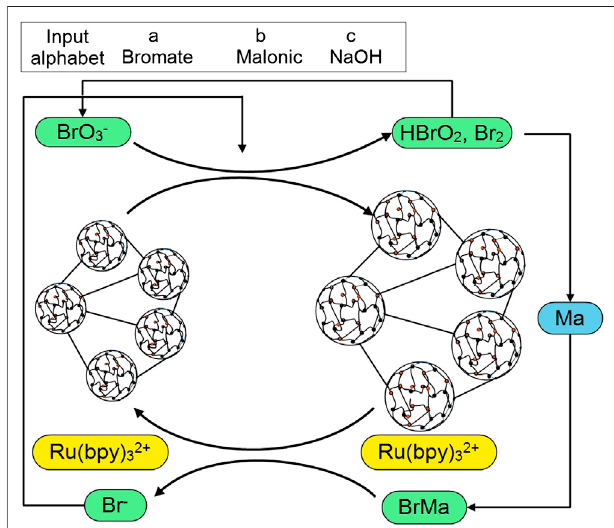
FIGURE 7 | Illustration of the acid/base reaction of L 3